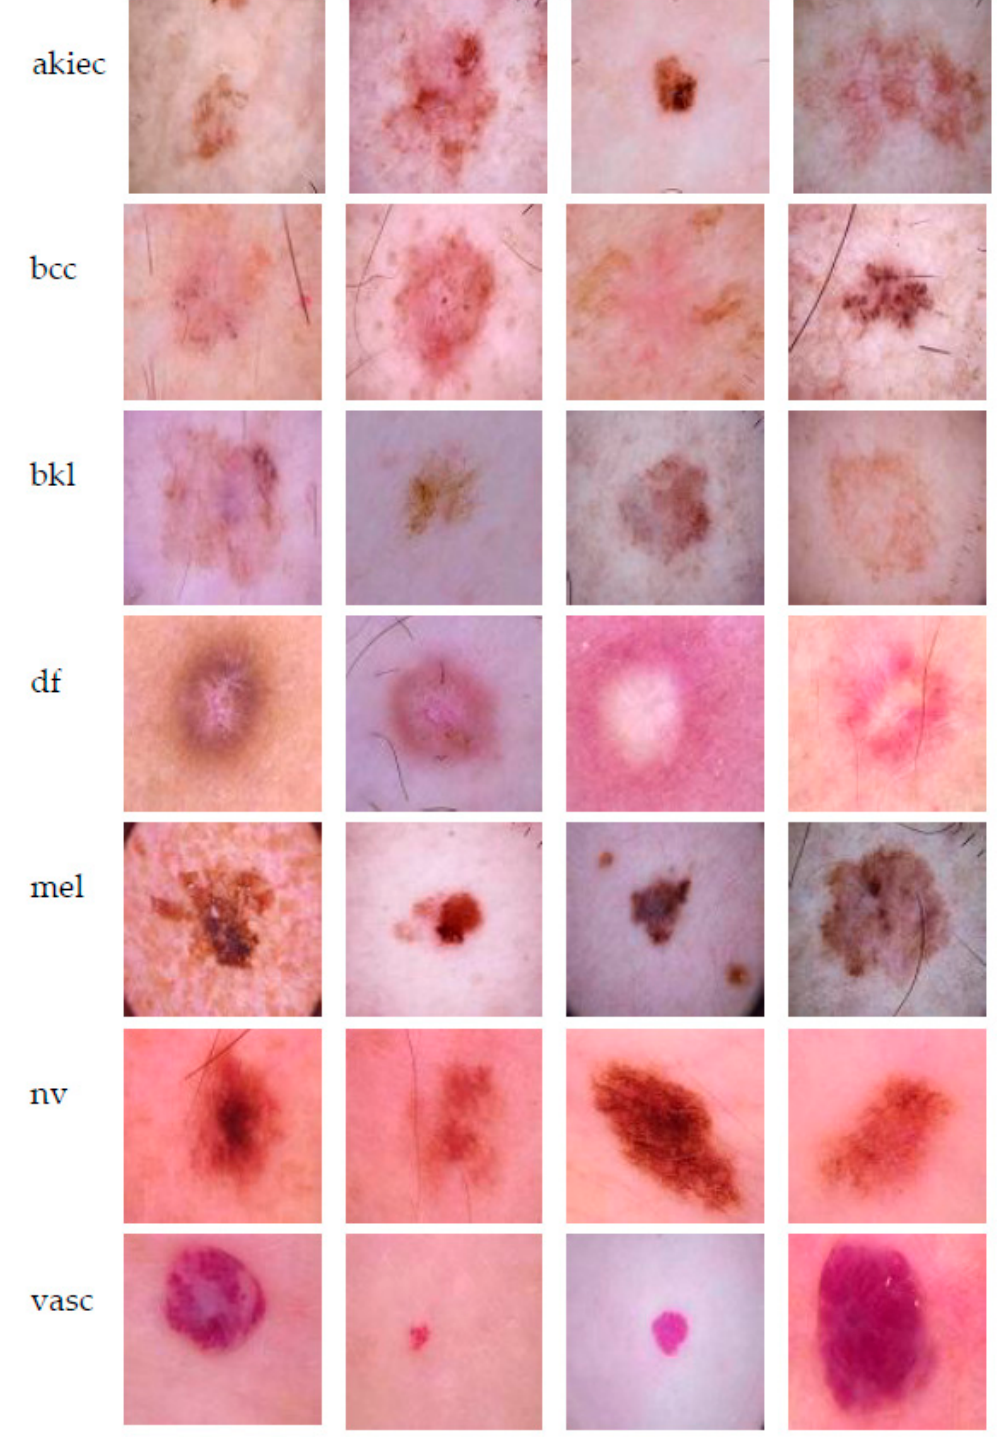
Figure 1. Example of each class from HAM10000 dataset [6].